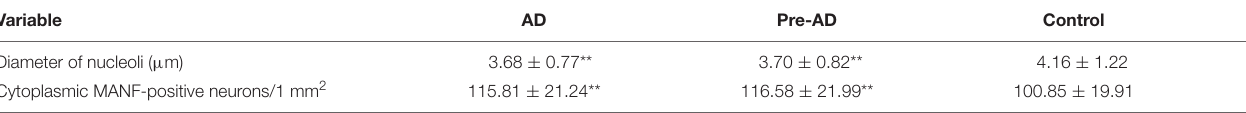
Frontiers in Aging Neuroscience |